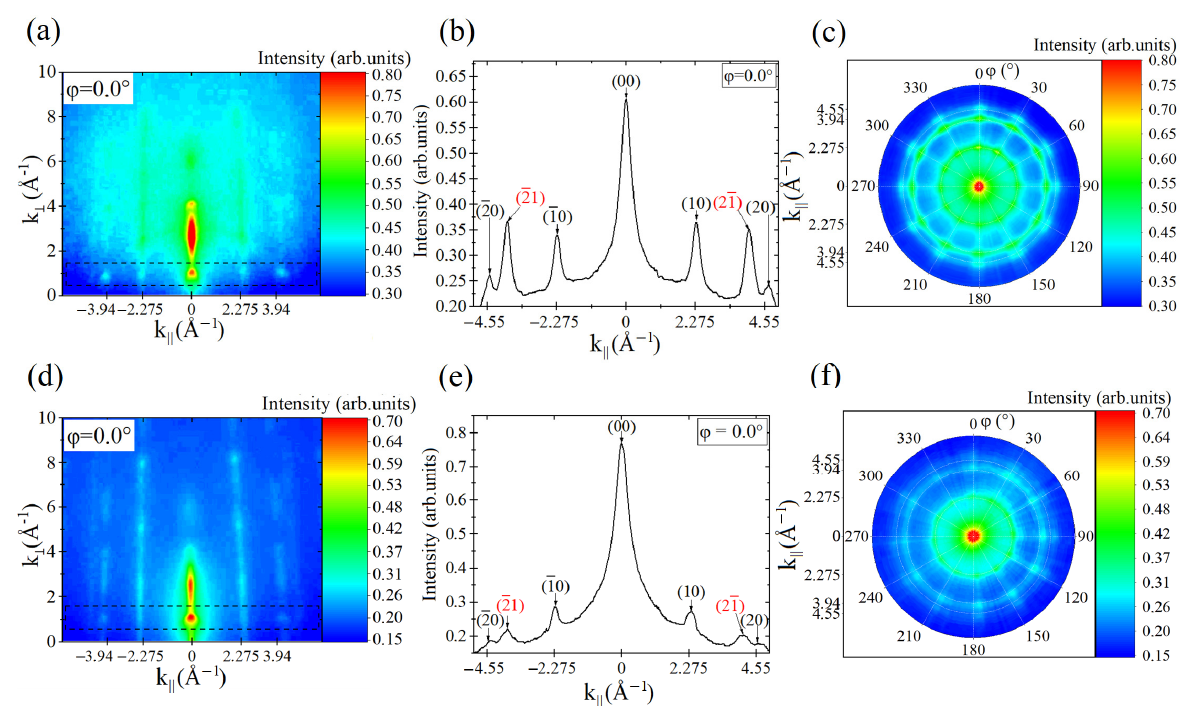
Figure 5. ( a , d ) Images of RHEED patterns from the GaN surface during PA-MBE growth on FLG ( a ) and MLG ( d ) at azimuthal angles φ = 0°. ( b , e ) Intensity profiles for azimuthal angles φ = 0° for the GaN layer growing on FLG ( b ) and MLG ( e ), respectively. ( c , f ) Structures of RHEED reciprocal spaces of the GaN layer grown on different graphene buffer layers: FLG ( c ) and MLG ( f) . Figure 4c,f shows the reciprocal space structures of the transferred FLG and MLG.